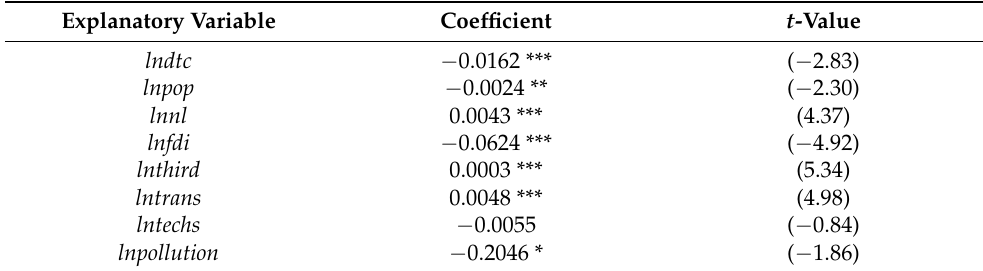
Table 3. OLS regression